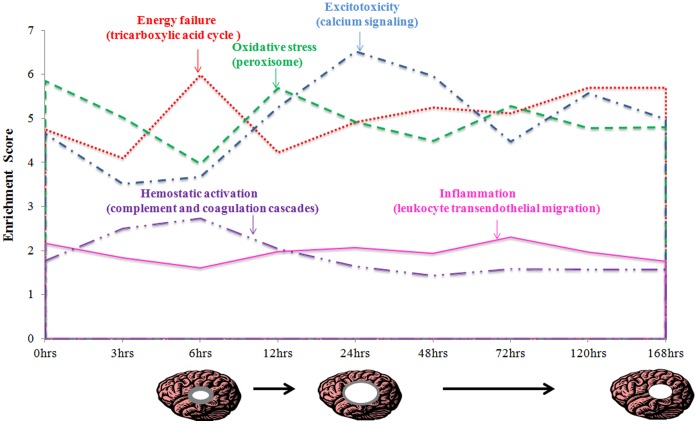
Graph representing the main pathological mechanisms occurring during cerebral ischemia.Infarct area (represented by white circle) becomes visible from about 6 hrs, reaches maximum at 24 hrs and decreases during recovery. The penumbra region which represents the on-going ischemic injury leading to the infarct expansion up to 24 hrs is shown as grey area.